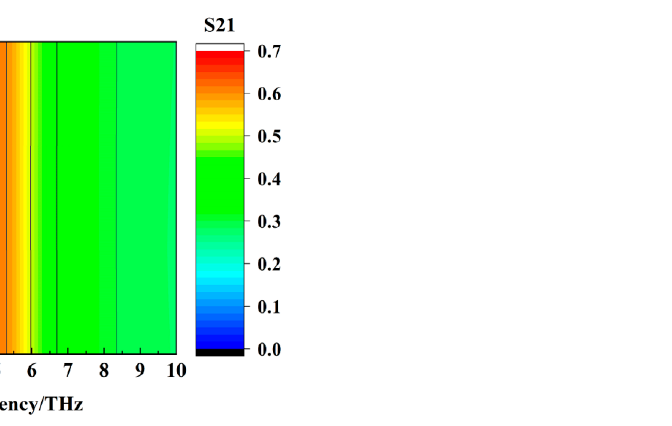
Figure 7. The wideband absorption property of the metamaterial absorber when the conductivity of